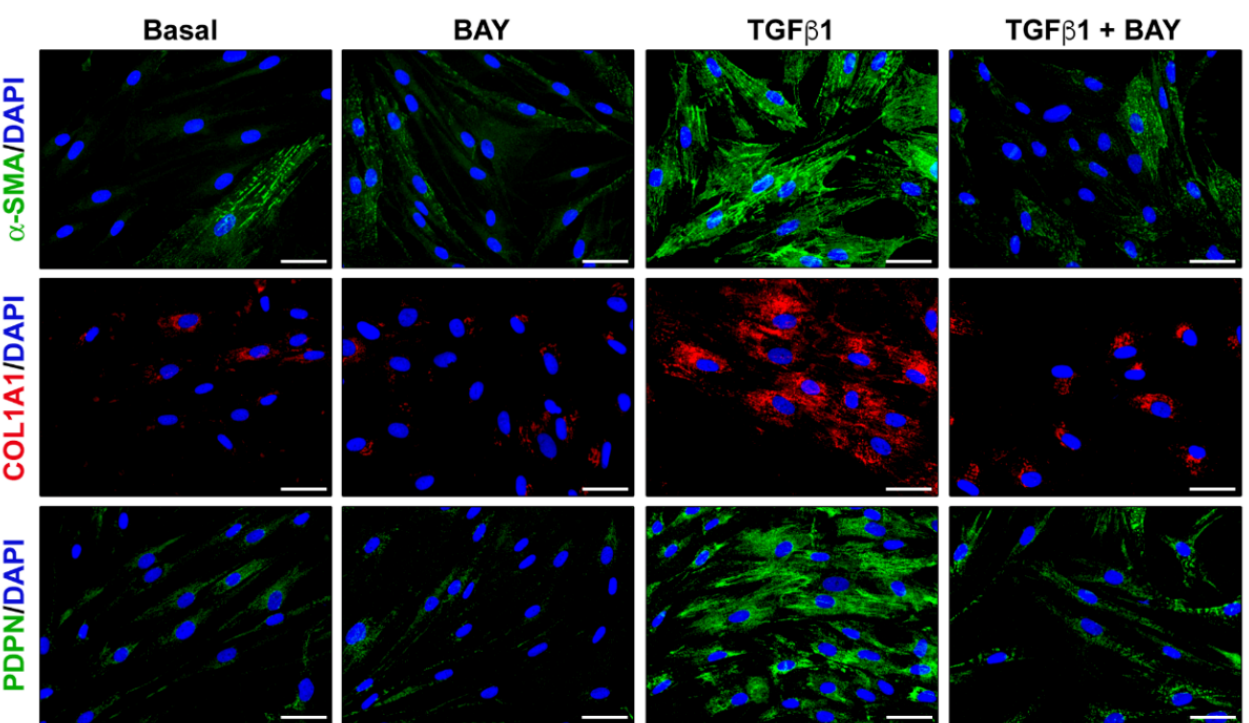
Figure 7. The soluble guanylate cyclase stimulator BAY 41-2272 significantly reduces TGF β 1-induced α -SMA stress fibers, COL1A1 synthesis, and PDPN immunostaining in human keratocytes. Representative fluorescence photomicrographs of keratocytes immunostained for α -SMA (green), COL1A1 (red), and PDPN (green) are shown. Nuclei are counterstained with 4 ′ ,6-diamidino-2-phenylindole (DAPI; blue). The assay was performed in duplicate for each of the five cell lines. Scale bar = 50 μ m. α -SMA, α -smooth muscle actin; COL1A1, α -1 chain of type I collagen; PDPN, podoplanin; TGF β 1, transforming growth factor β 1.